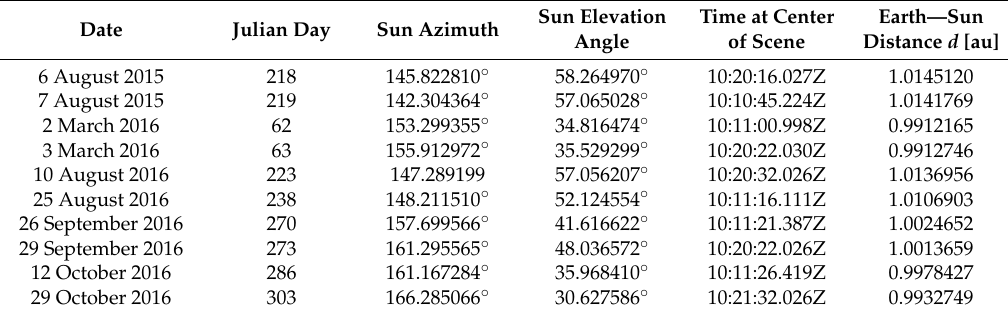
Table 4. Astronomic coefficients used within the Moran radiative transfer model (RTM) during images